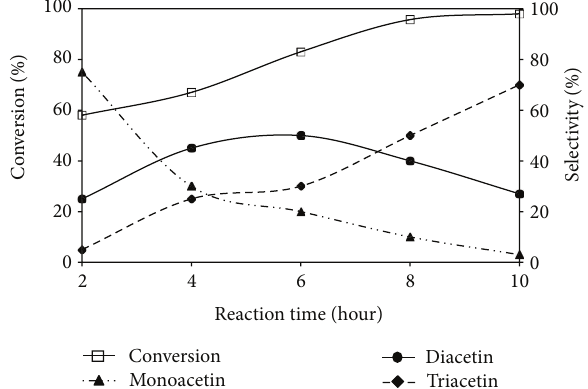
Figure 11: Influence of reaction time on conversion and selectivity for WO 3 -Ppy-20 catalysts. (Reaction temperature: 110 ∘ C; catalyst weight: 0.4g; AcOH/Gly mole ratio: